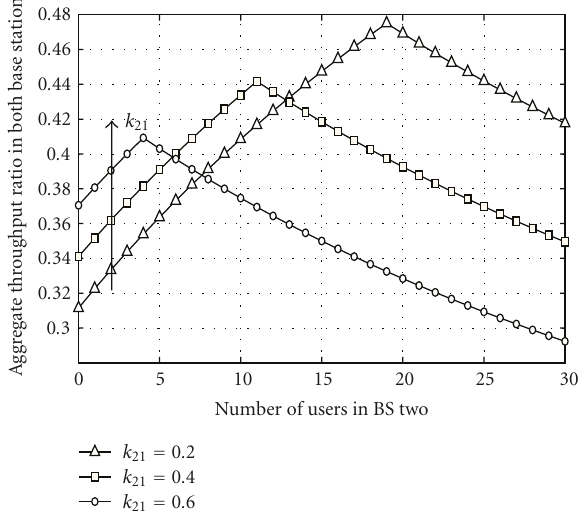
Figure 6: The aggregate throughput ratio in both base-stations versus the number of added users in BS 2 for di ff erent values of k 21